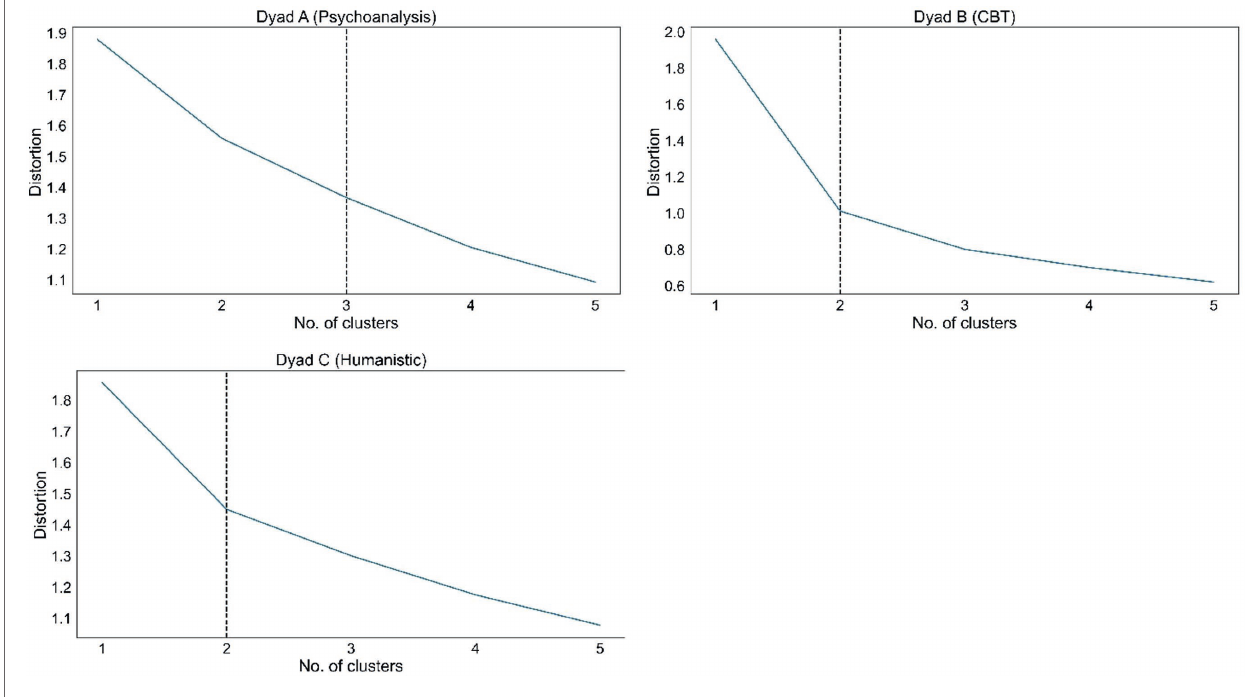
FIGURE 1 | Elbow plots for the three